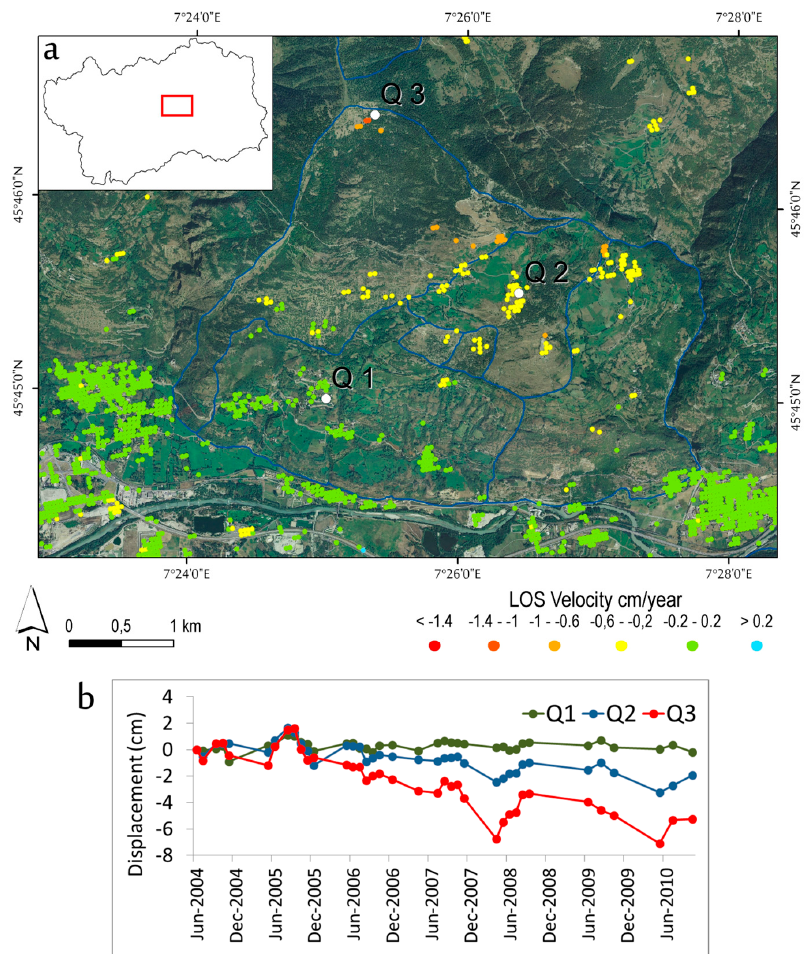
Figure 9. ( a ) Mean deformation velocity map of Quart DsGSD case study, for Envisat ascending dataset. ( b ) Time series corresponding to the targets signed by the white dots in the map.